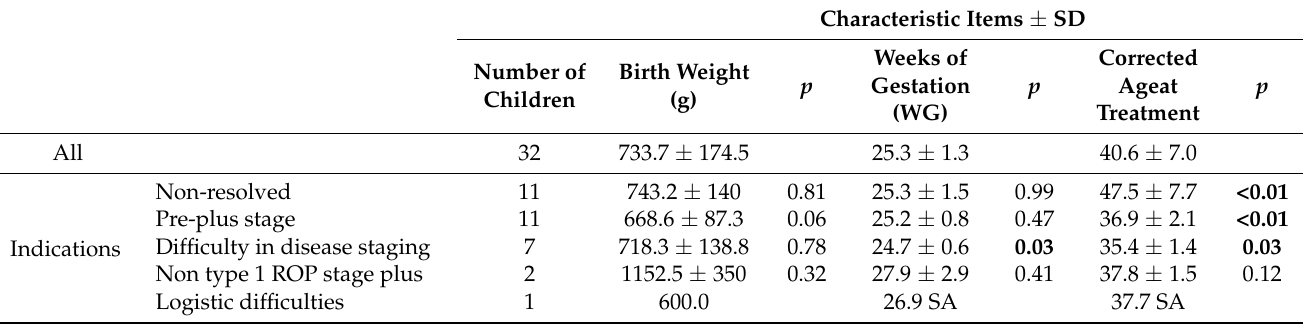
Table 3. Group 1 indications